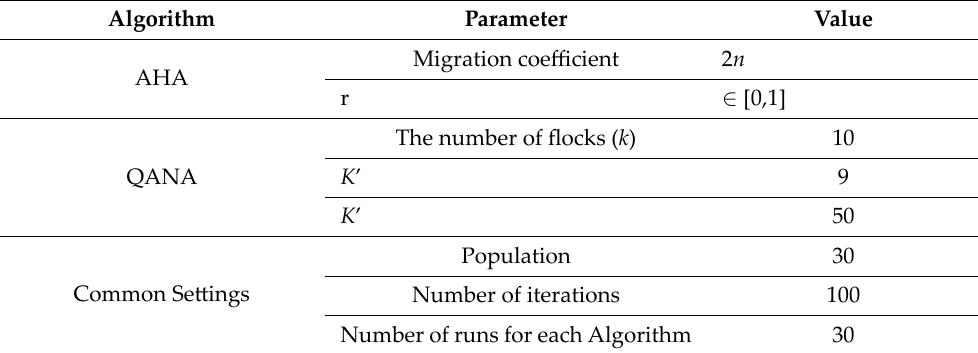
Table 2. Parameter settings for all algorithms.